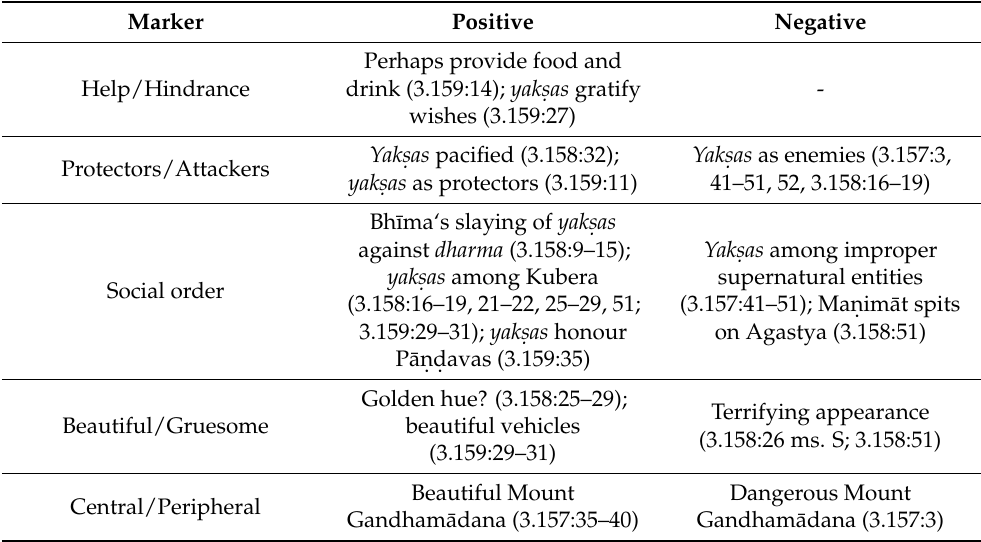
Table 3. Evaluation of the yaks.as in the Second War of the Yaks.as . Marker Positive Negative Perhaps provide food Help/Hindrance